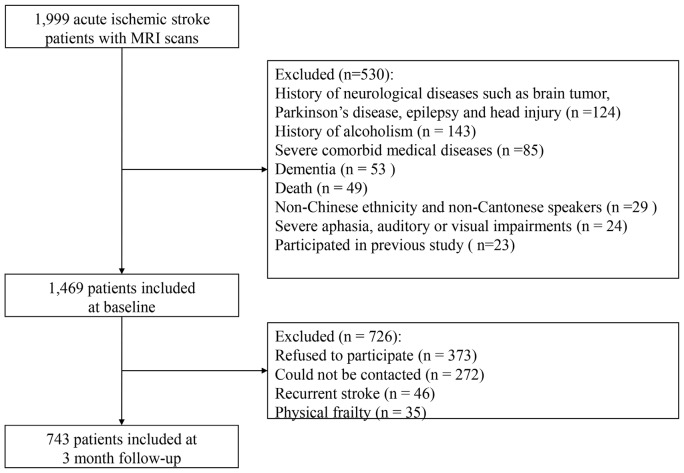
Flow chart of recruitment.